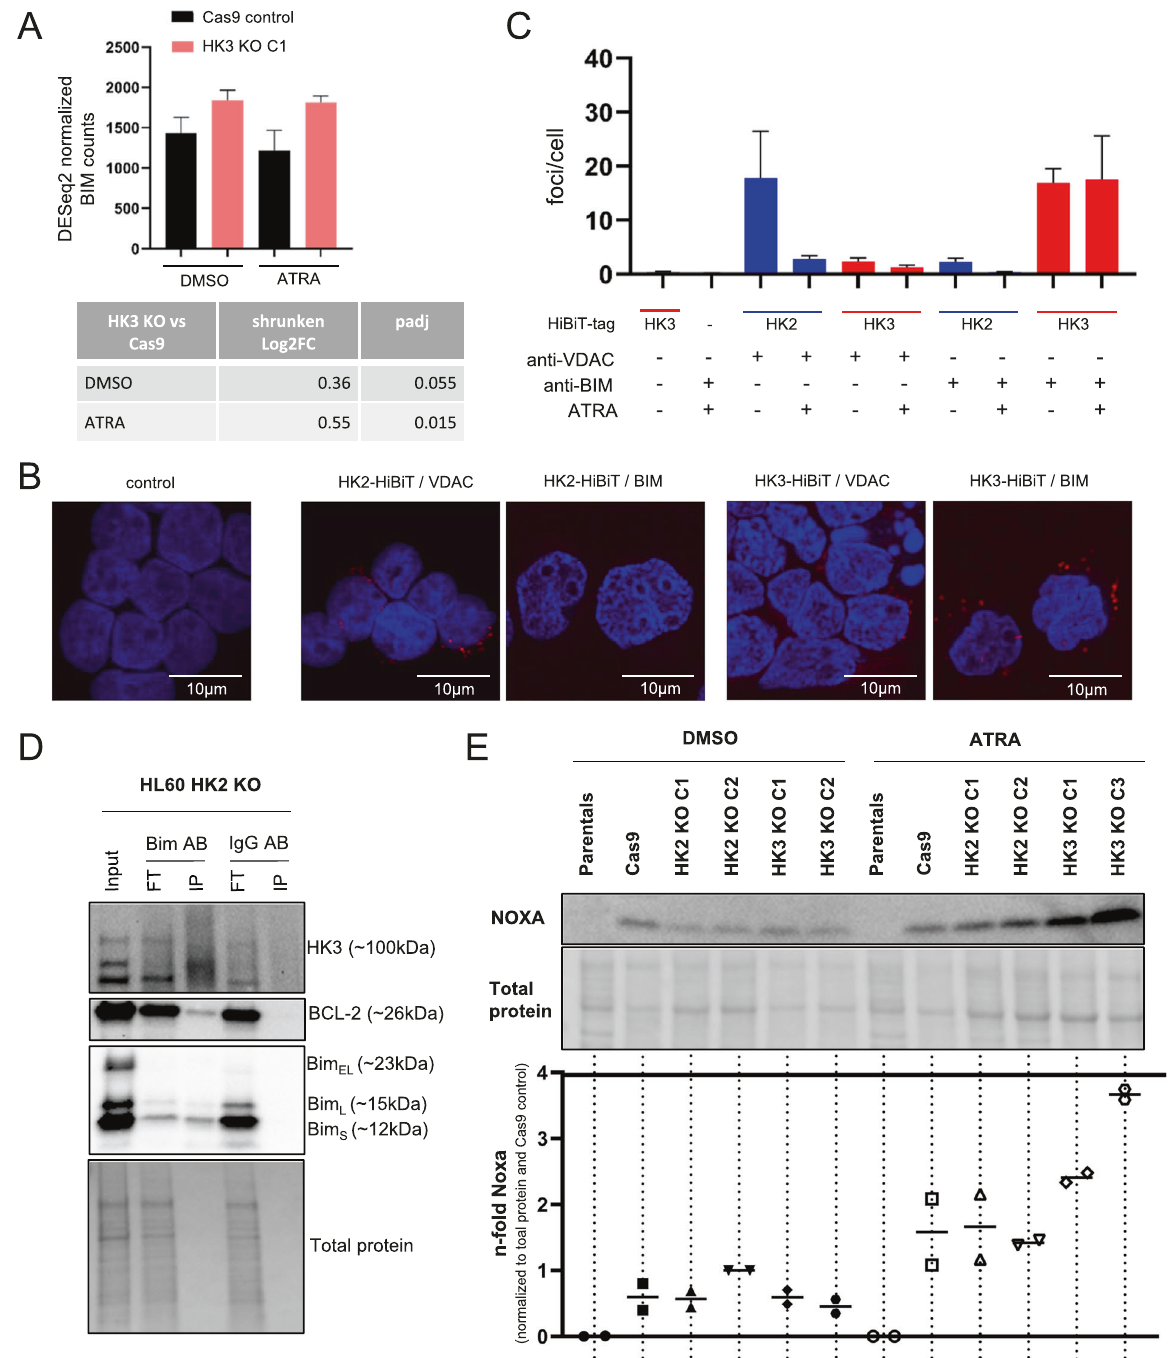
Fig. 6 HK3 interactome reveals interaction with BH3-only protein BIM. A DESeq2 normalized counts and differential expression analysis of BIM transcript expression in HK3 -null cells and control ±ATRA. Data represent the mean of three biological replicates. B Confocal imaging of proximity ligation assay (PLA) using either endogenously HiBiT-tagged HK2 or HK3 HL60 cell lines. Fluorescent foci indicate the colocalization of proteins. Primary antibodies used were mouse anti-HiBiT, combined with rabbit anti-VDAC or rabbit anti-BIM. Control: secondary antibodies only. C PLA quanti fi cation. Negative controls: First column, secondary antibodies only, second column HL60 not expressing a HiBiT-tag ( n = 2, 2 technical replicates each, mean ± SEM). Anti-VDAC was used as a positive control for HK2 interactions. D Co-IP of HK3 and BIM. IP was performed in HL60 HK2 -null cells treated with ATRA for 2 days using an anti-BIM antibody immobilized on Protein A/G magnetic beads. HK3, BCL-2, and BIM immunoblotting of fl owthrough (FT) and pulled-down (IP) proteins are shown. BCL-2, a known BIM interacting protein, was used as a positive control. E NOXA western blotting of HL60 control, HK2 - and HK3 -null cell lines treated for 4 days with DMSO or ATRA. Quanti fi cation of NOXA protein expression of two independent experiments is shown below. NOXA expression was normalized to total protein and Cas9 control cell